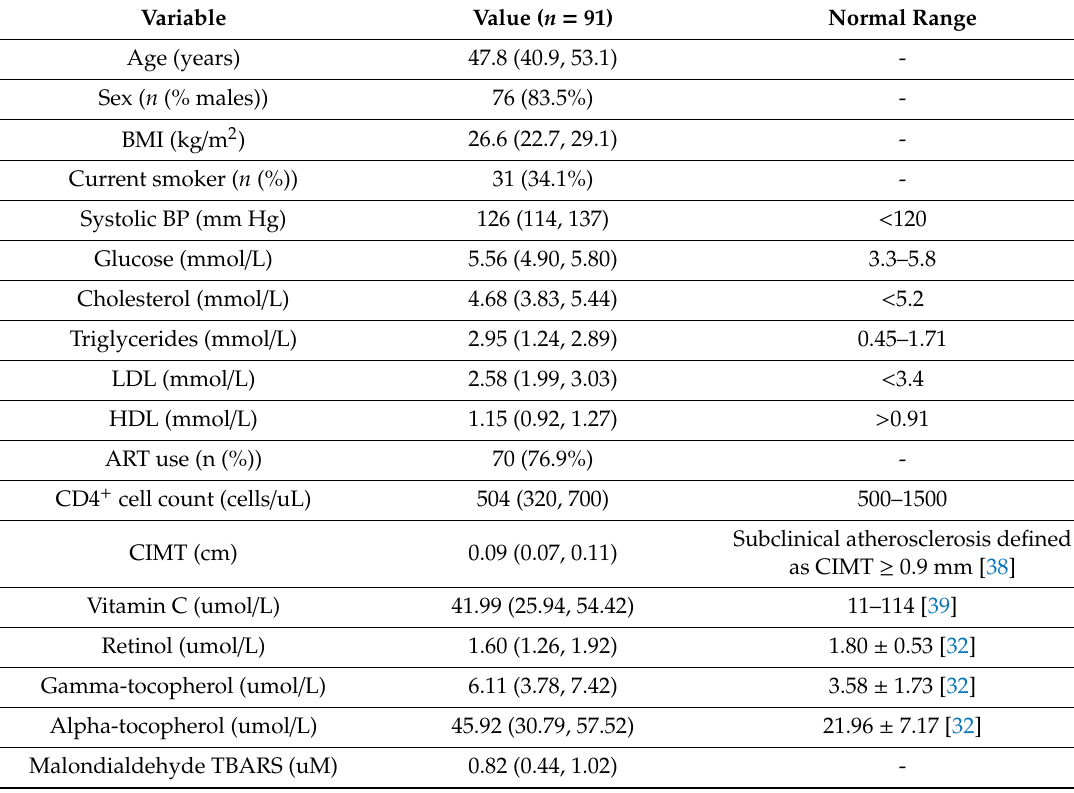
Table 1. Demographic and clinical